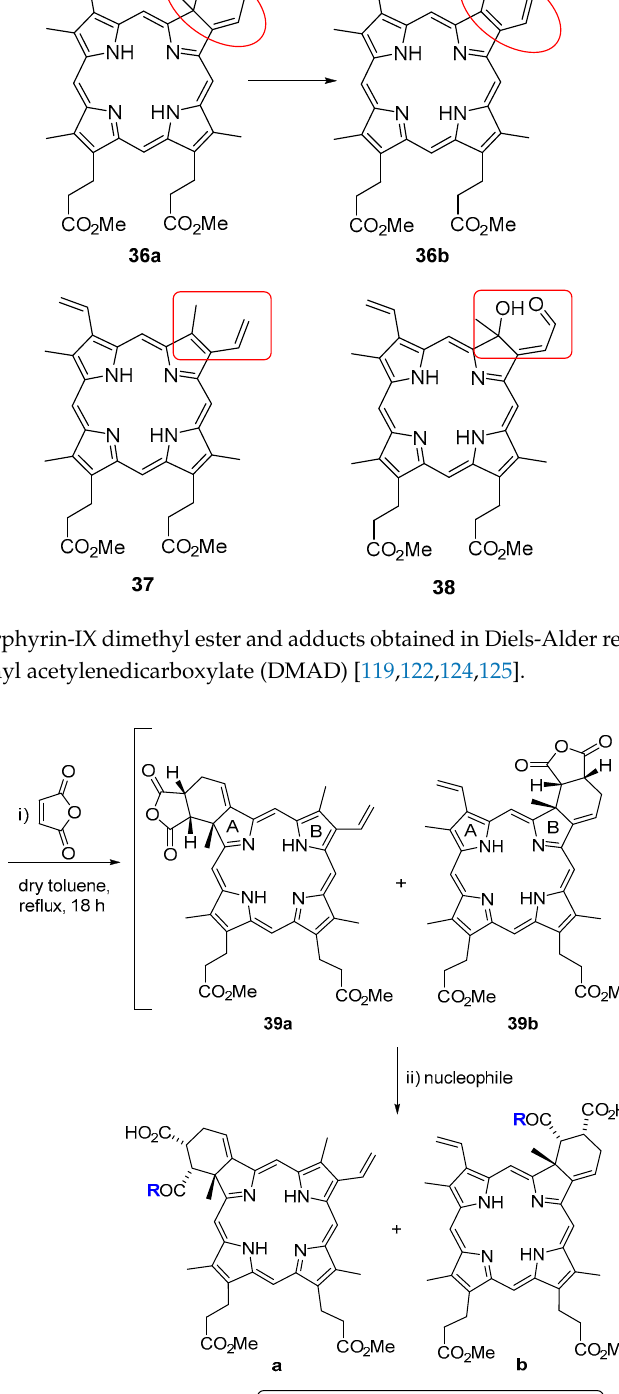
Figure 13. Adducts obtained in the reaction of protoporphyrin-IX and protoporphyrin-II dimethyl esters with p -nitronitrosobenzene [130]. The use of β -vinyl- meso -tetraarylporphyrins as dienes in Diels–Alder reaction was investigated for the first time in 1996 [131]. Faustino et al. showed that the reaction of Ni 31 with TCNE affords adducts 47 and 48 that result, respectively, from [4 + 2] and [2 + 2] cycloaddition processes (Scheme 14). The NMR studies showed that the formation of the [2 + 2] adduct can occur by rearrangement of the [4+2] chlorin. The reaction of β -vinylTPP Ni 31 (Ar = Ph) with DMAD afforded chlorin 49 and the benzoporphyrin 50 ; the oxidation of 49 with DDQ afforded quantitatively the benzoporphyrin 50 [132]. Similar results were reported by Matsumoto et al. [133].